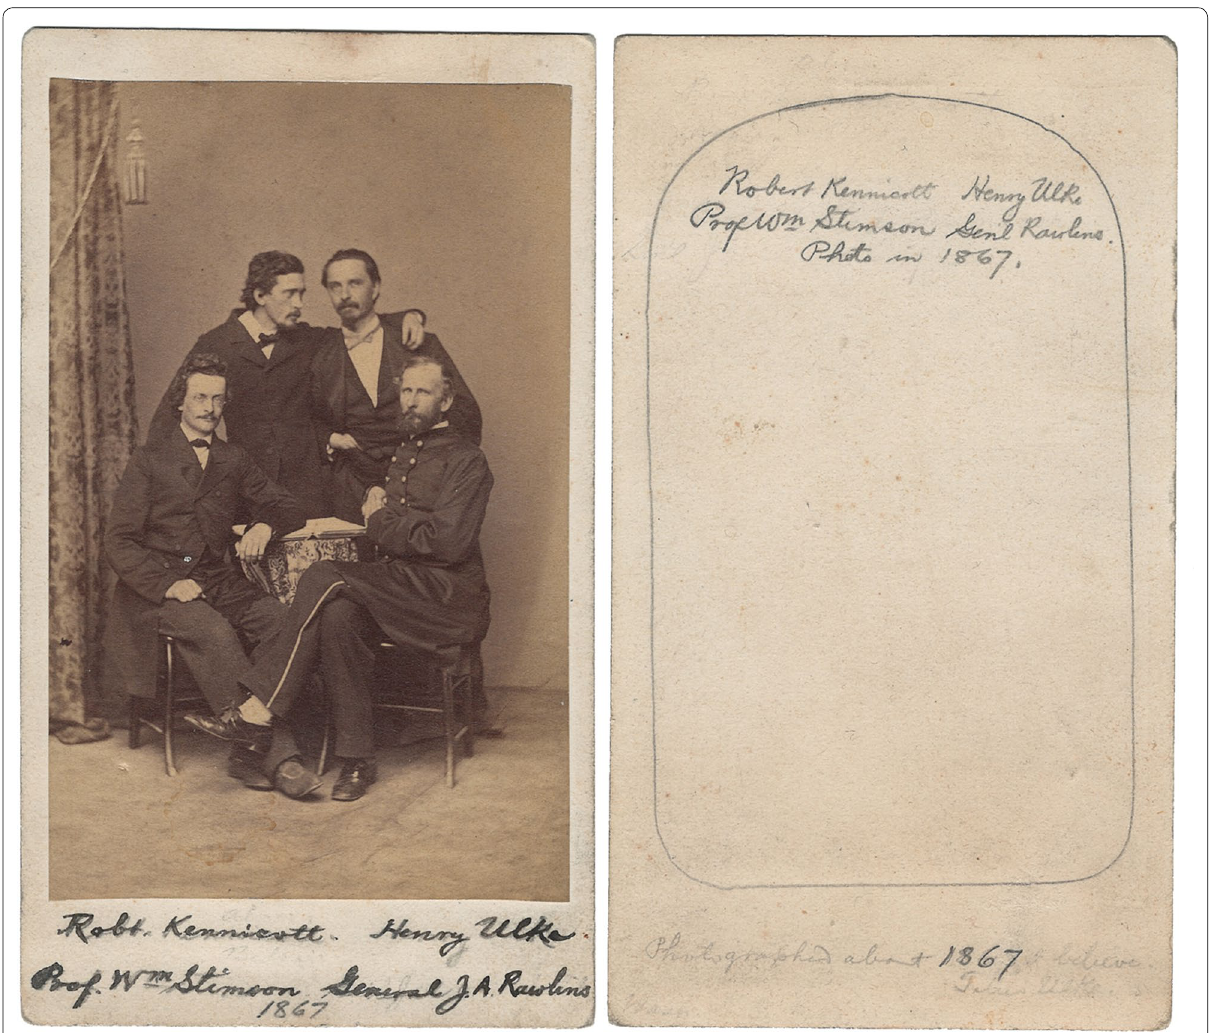
Fig. 3 Megatherium Club members’ carte-de-visite (ex Ulke Family Collection, Swann 2013, sale 2324, lot 335), including William Stimpson, founder (bottom left), Henry Ulke (top right), Robert Kennicott (top left) and Henry Bryant (bottom right; for identification see, e.g., Herber 1963, pl. 15); note that in this copy, the latter person was identified as ‘General J.A. Rawlins’, dated ‘1867’, but obviously taken before as Kennicott died in May 1866; courtesy of ERB